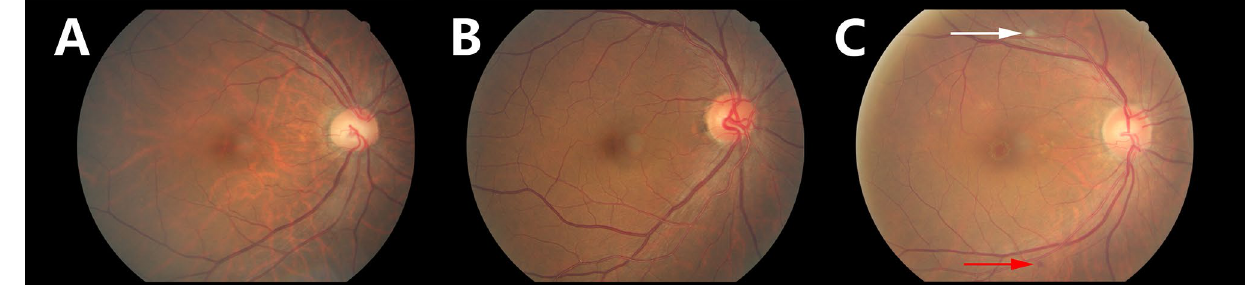
Figure 1. Classification of hypertensive retinopathy. ( A ) Mild hypertensive retinopathy (slight or modest narrowing of retinal arterioles with an arterial: venous ratio of more than 1:2). ( B ) Modest hypertensive retinopathy (modest to severe narrowing of retinal arterioles with an arterial: venous ratio less than 1:2 or arteriovenous nicking). ( C ) Severe hypertensive retinopathy (cotton wool spot and flame-shaped hemorrhages, or optic nerve edema); white arrow: cotton wool; red arrow: